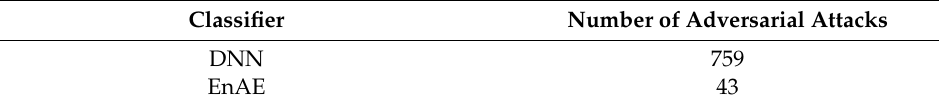
Table 11. Number of successful adversarial attacks on classifiers.